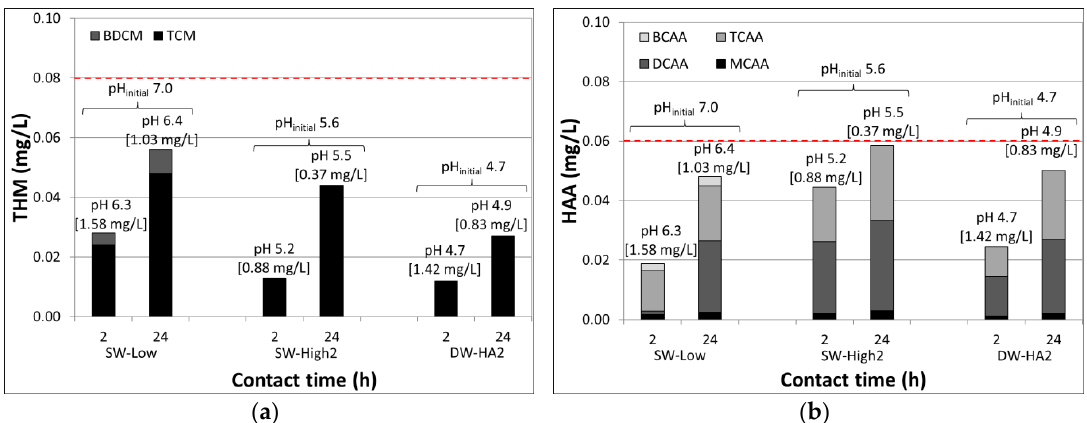
Figure 3. Total trihalomethane (THM) ( a ) and haloacetic acid (HAA) ( b ) formation at 2 and 24 h after treatment with AQS alongside pH and free chlorine residual (FCR) (in square brackets) at different sampling times. Dashed lines represent USEPA [21] maximum contaminant limits of 0.080 mg/L and 0.060 mg/L for THMs and HAAs, respectively.